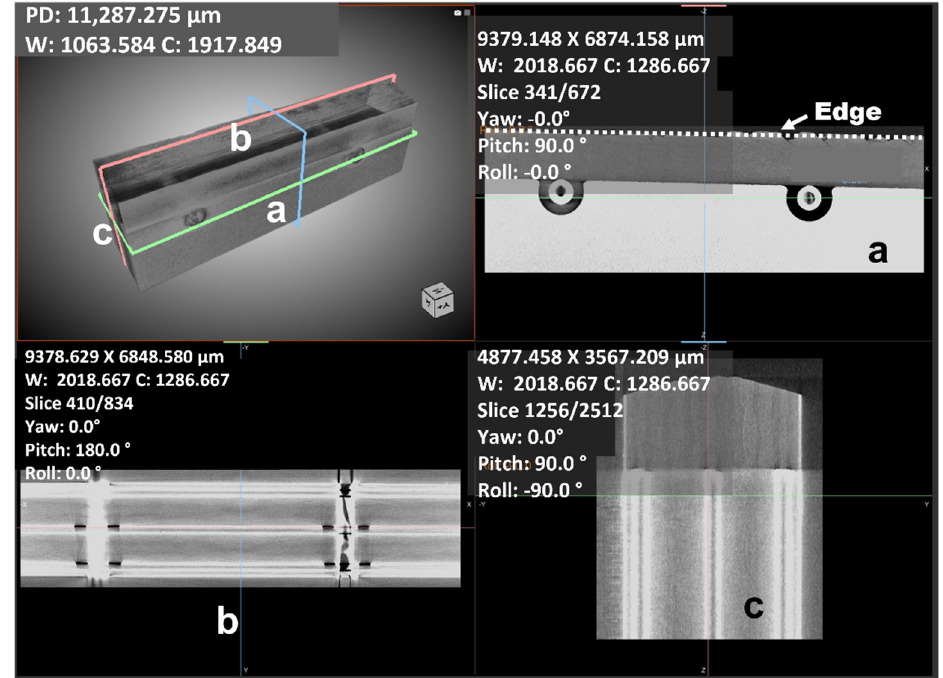
Figure 5. Image dataset reoriented with a new image plane as shown by the pink color in the 3D image (top left side). The 2D images are taken at the: front side ( a ); top side ( b ); left side ( c ).